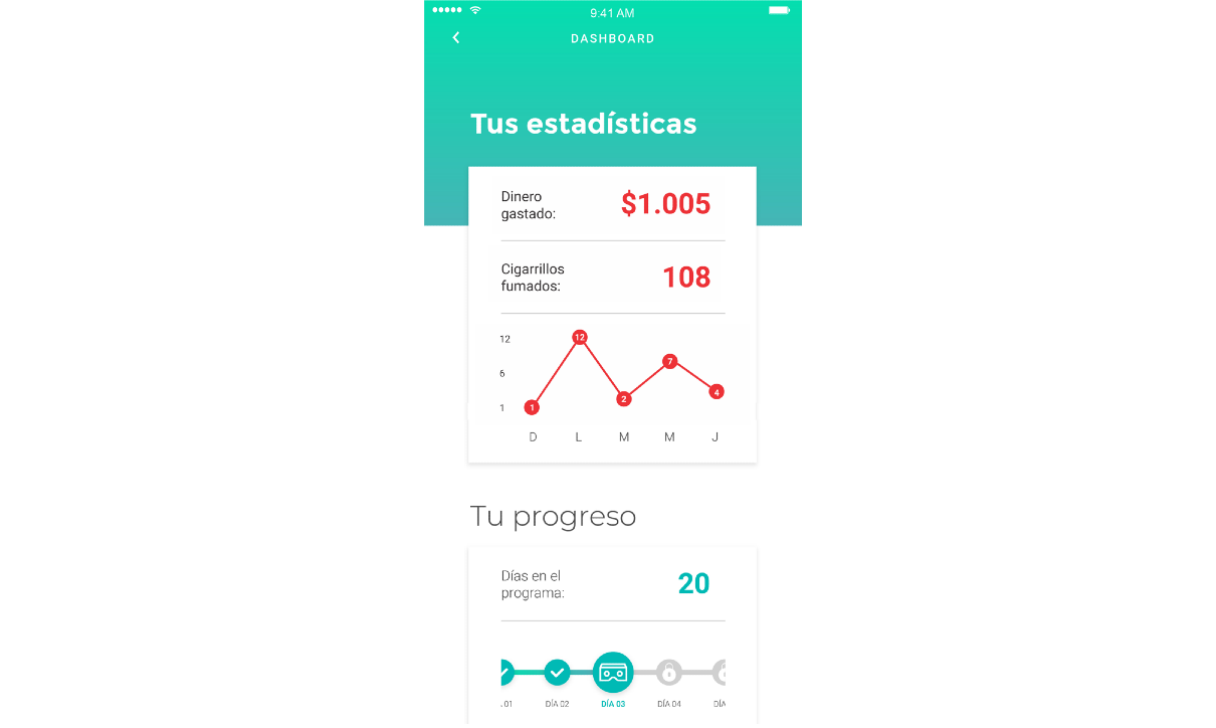
Figure 5. App screenshot on the dashboard showing statistics about money and the number of smoked cigarettes.